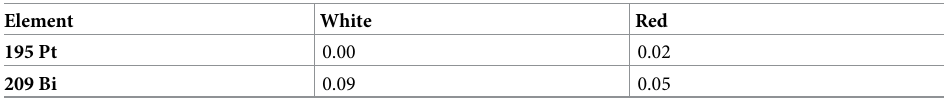
Although data for wine type was not statistically significant, certain metal contents such as Fe, Zn or Al revealed differences coherent with results reported in the